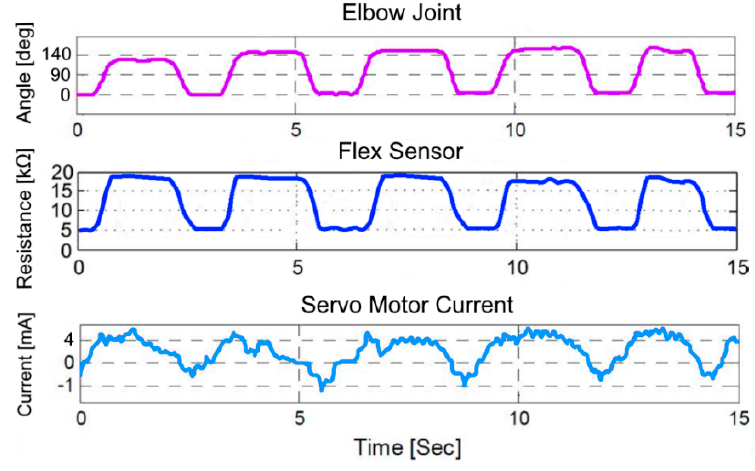
Figure 22. Elbow joint motion, filtered flex sensor output, and current drawn by servo motor during the extension and flexion task.